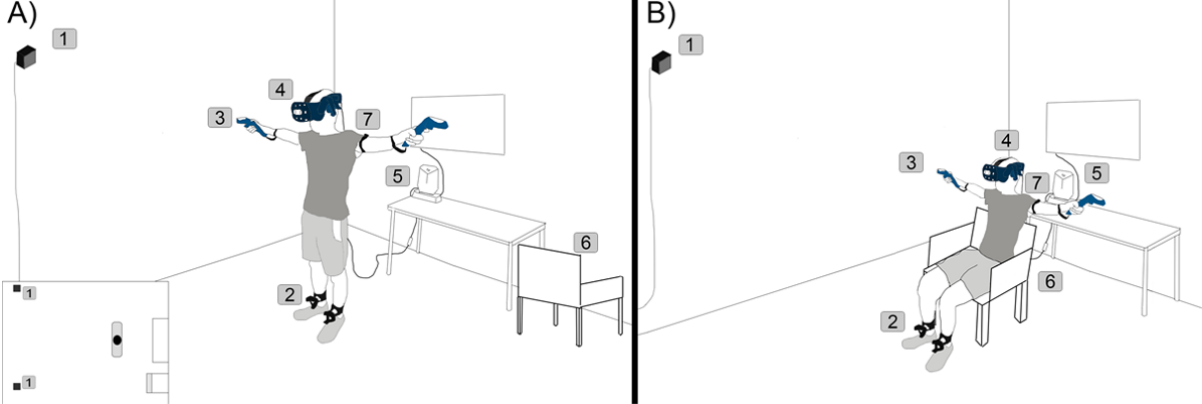
Figure 3. Standing (A) and seated (B) experiment setup, and the devices used in the experiment: (1) the HTC VIVE base stations, the locations of the two base stations can be found in the vertical view in the left bottom corner; (2) the two VIVE trackers attached to the legs; (3) the VIVE controllers used to track the player’s hand positions; (4) HTC VIVE Pro Eye; (5) the HP Z backpack; (6) the chair; and (7) Polar